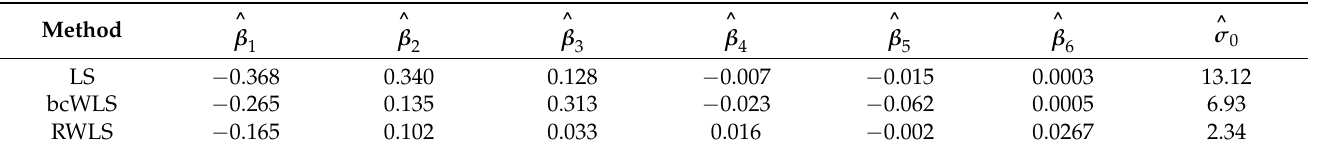
Table 9. Parameters of DTM estimation and